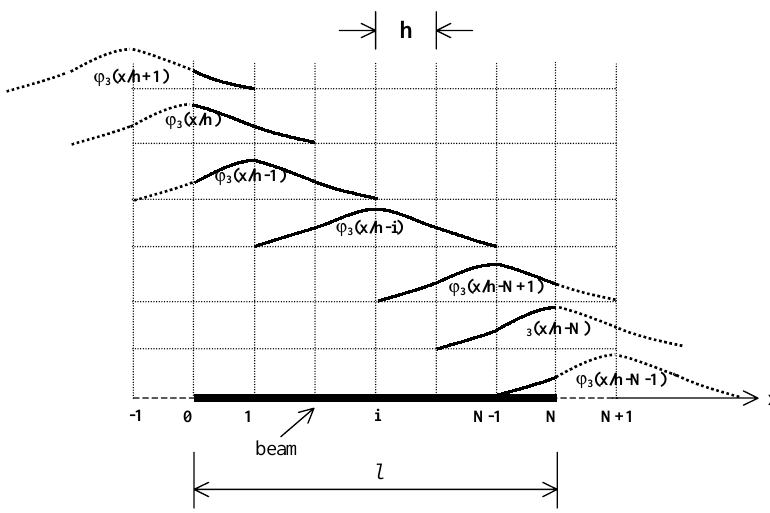
Fig. 2. Beam function interpolation by ordinary cubic B-spline